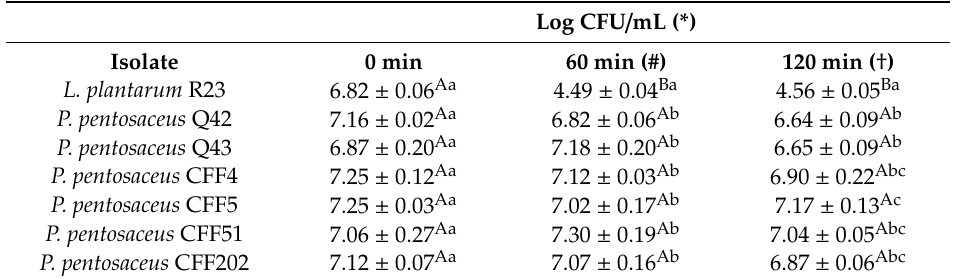
Table 3. Survival of seven LAB isolates through simulated gastrointestinal (GI) tract